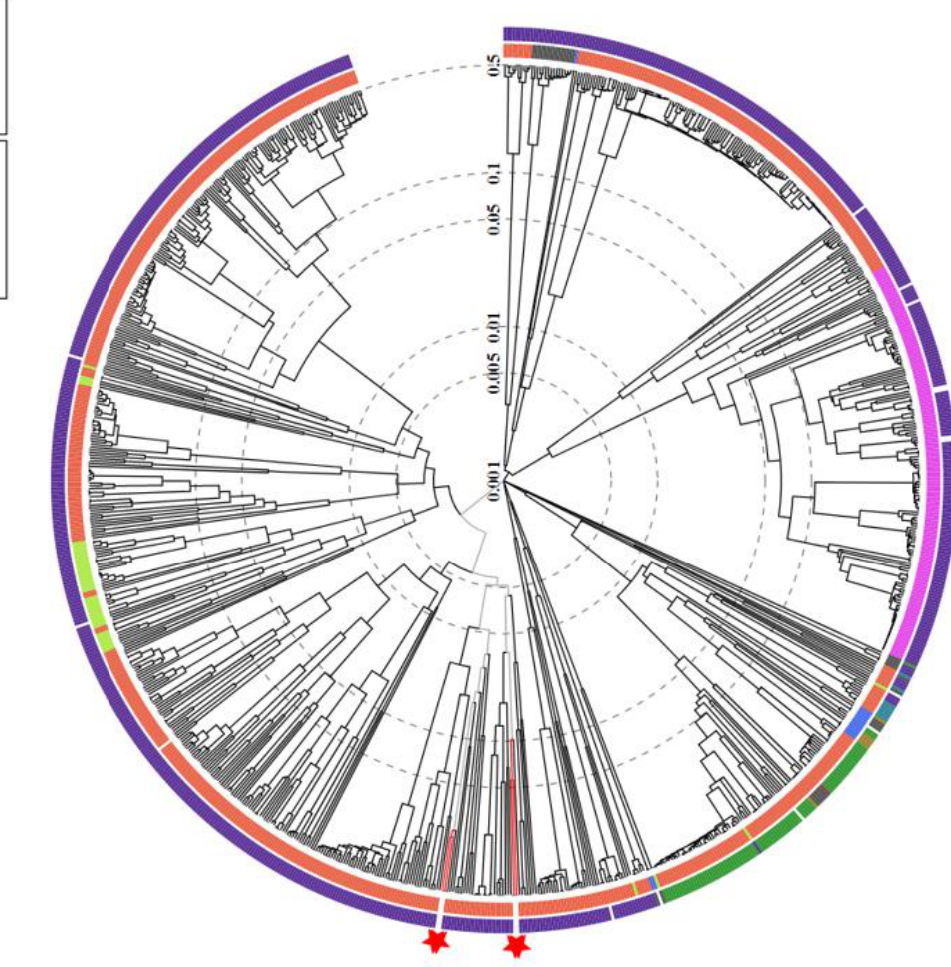
Figure 5. Circular proteomic tree of the viral genome sequences. The four hypothetical prophages are marked with a red star in the graph with all related viral genomes. The outermost ring presents the host group of bacteriophages; the inner ring symbolizes the virus family of phages.